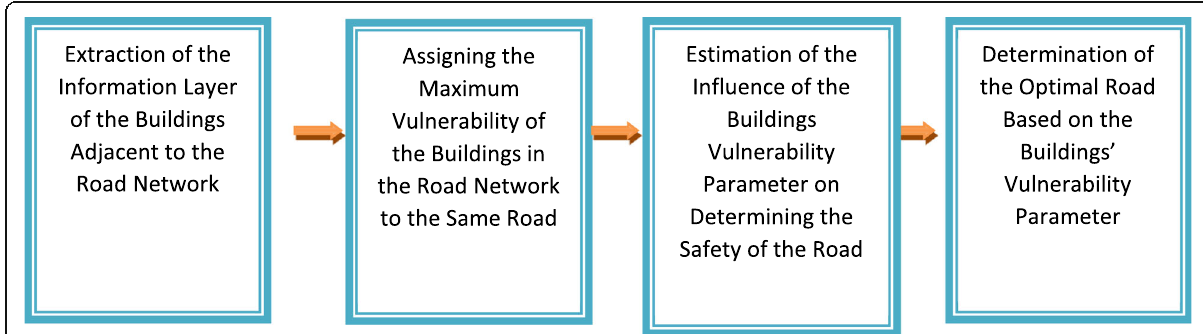
Fig. 8 Estimating method of building vulnerability adjacent to road network parameter and its optimal road determination